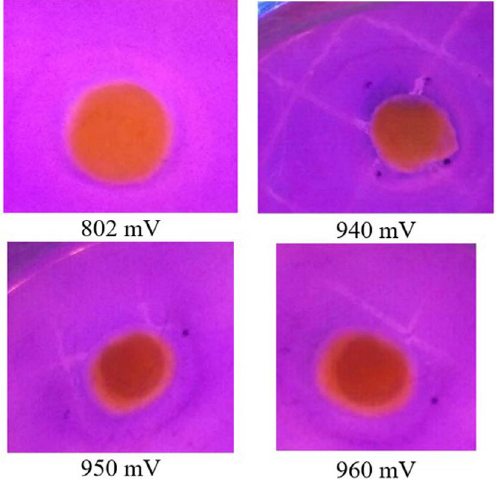
Fig. 6. a. Before treatment ; b. After treatment